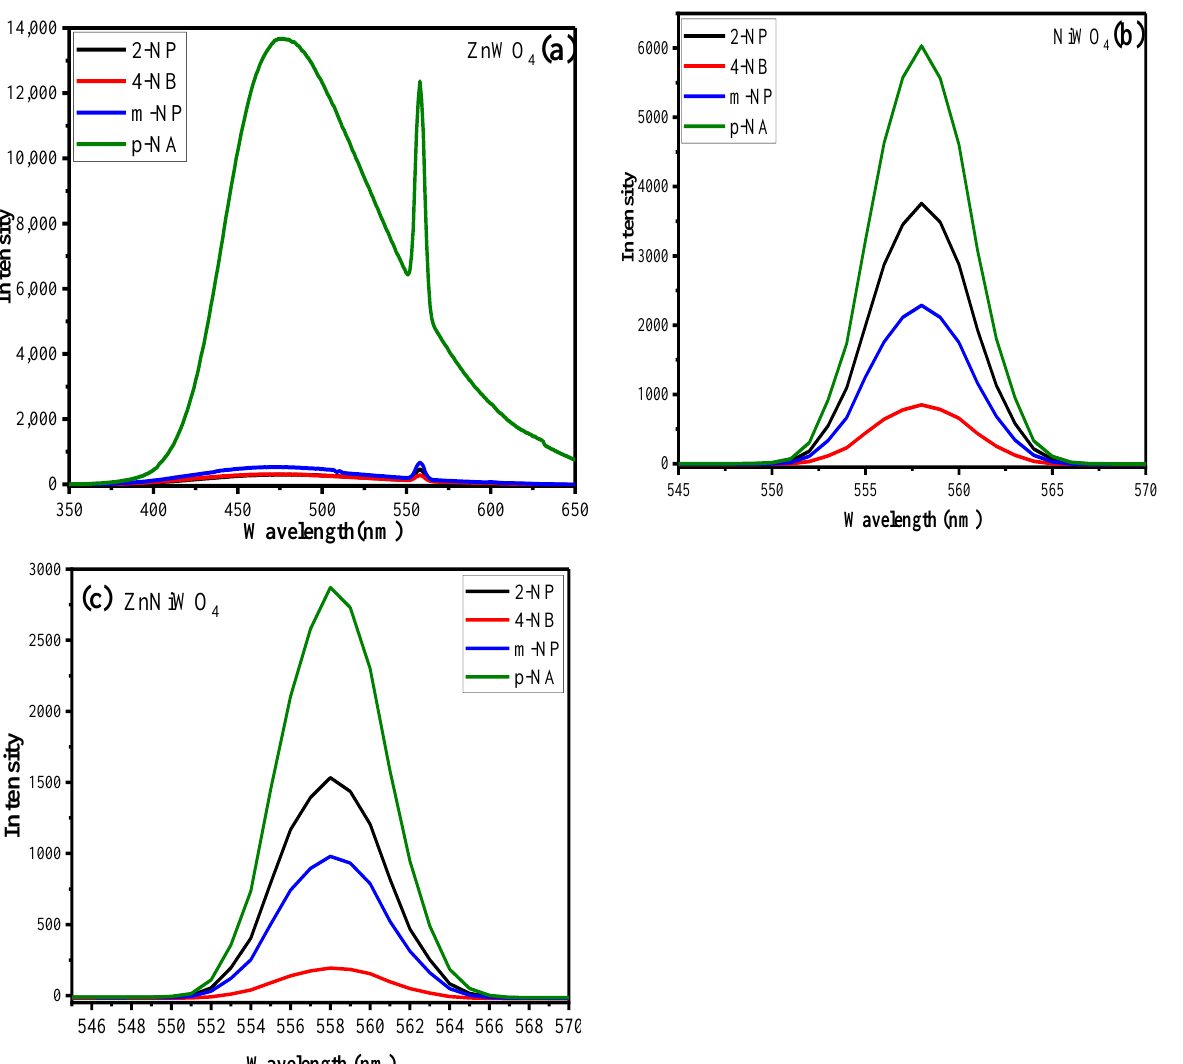
Figure 9. Effect of various nitroaromatics on the fluorescence spectra of ( a ) ZnWO 4, ( b ) NiWO 4, and ( c ) ZnNiWO 4, recorded at 320 nm excitation wavelength.